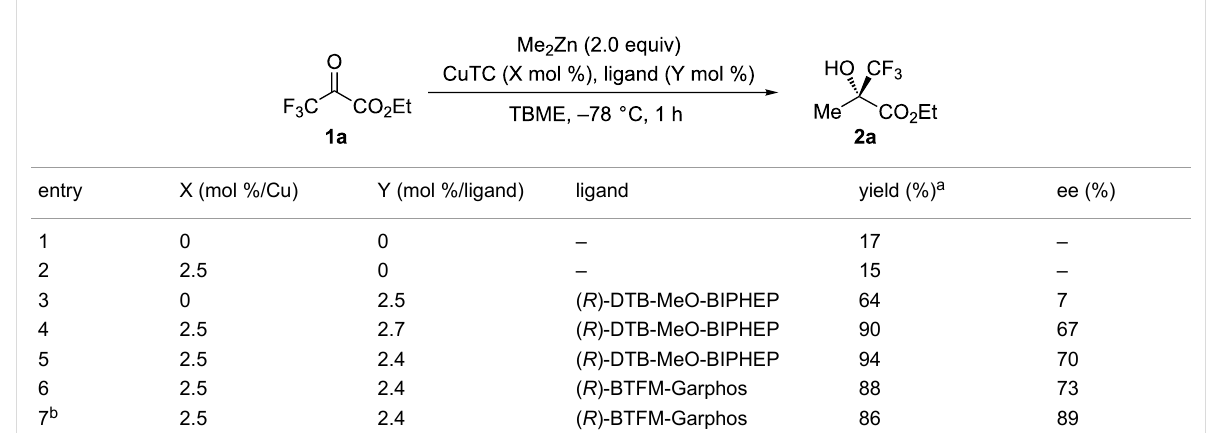
Table 2: Optimization of reaction